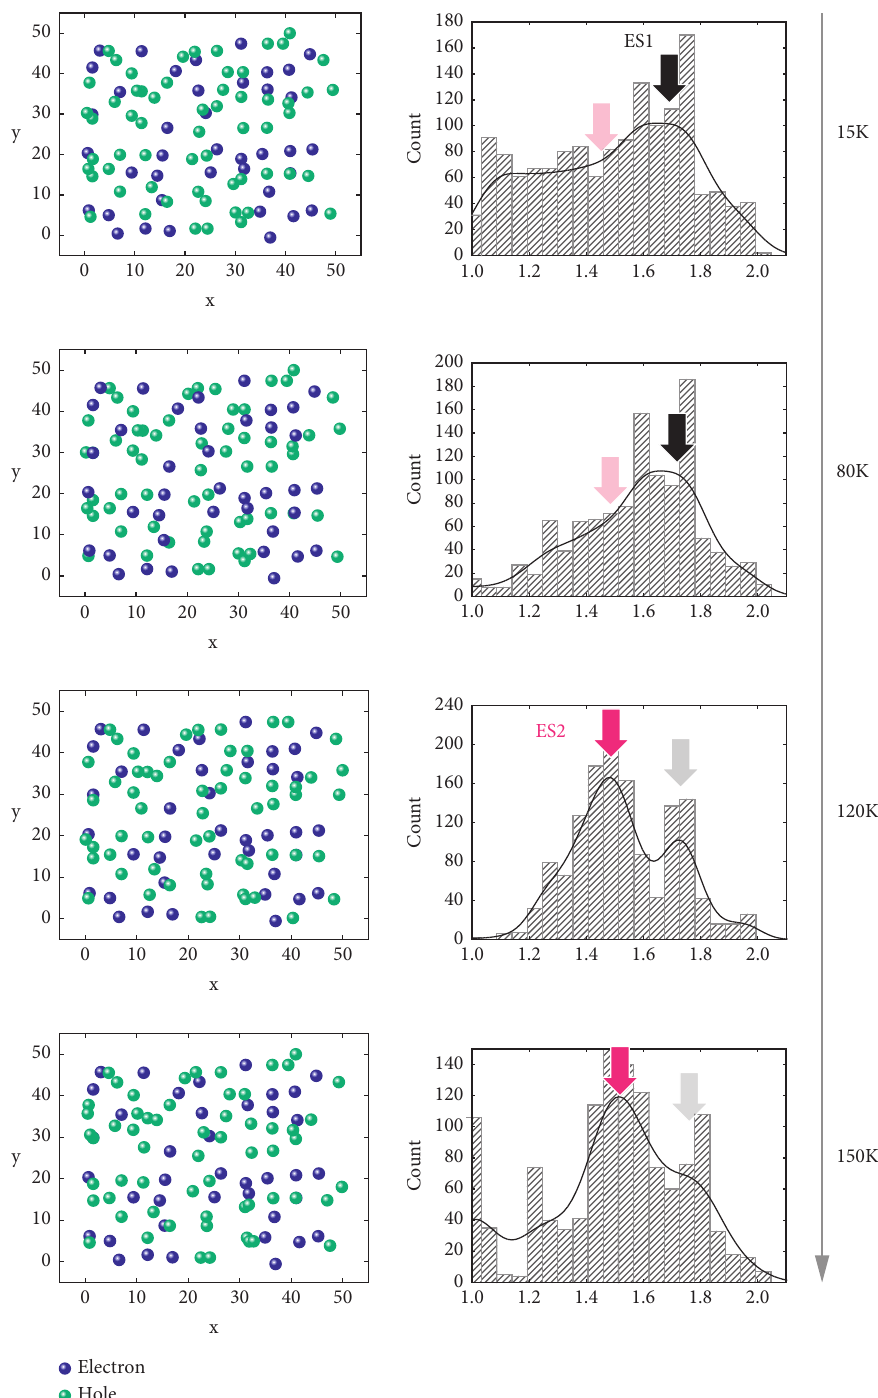
Figure 5: Simulation results of hybrid of Adiabatic quantum annealing simulator with Metropolis-adjusted stochastic gradient Langevin dynamics. The ratio of the number of electrons to the number of holes is 4:6 and the total number is set as 100. The holes update position based on the stochastic gradient Langevin dynamics as well as metropolis acceptance probability at four typical temperatures: 15K, 80K, 120K, and